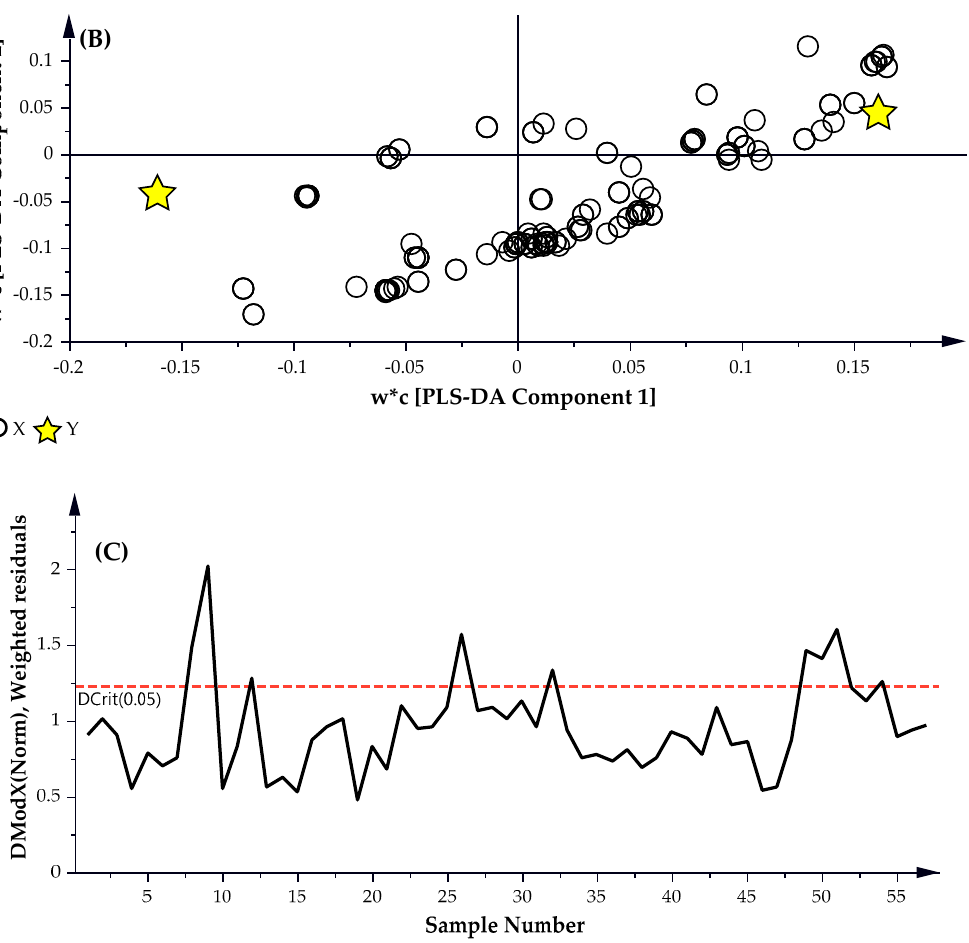
Figure 3. ( A ) PLS-DA Scatter plot, ( B ) PLS-DA Loadings Scatter Plot and ( C ) DModX’ or ‘Distance of observation’ plot of the analyzed lavender oil samples by untargeted GC-MS.